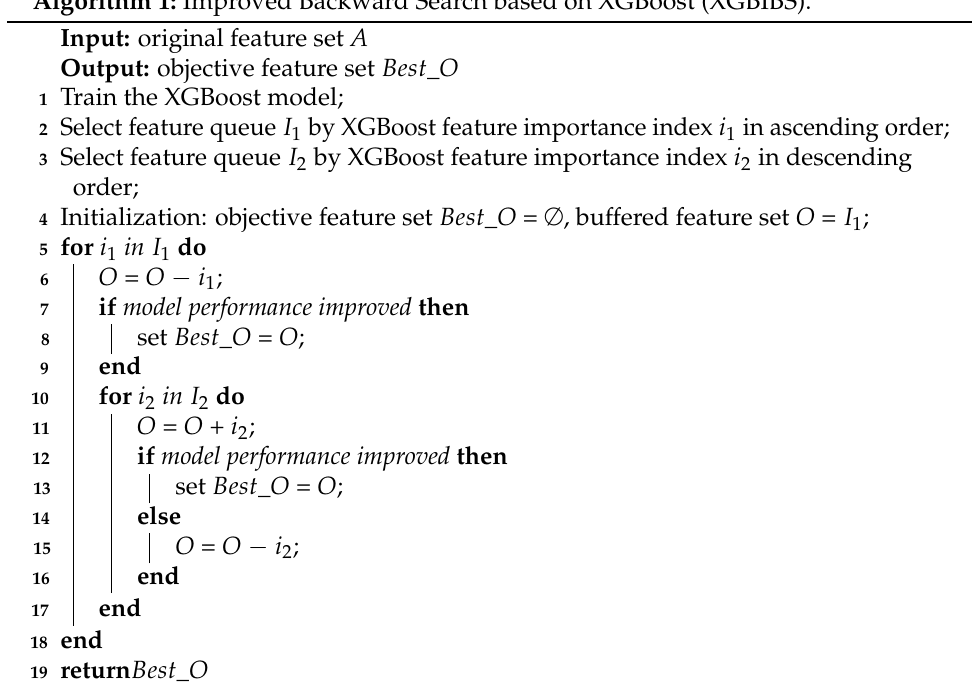
Algorithm 1: Improved Backward Search based on XGBoost